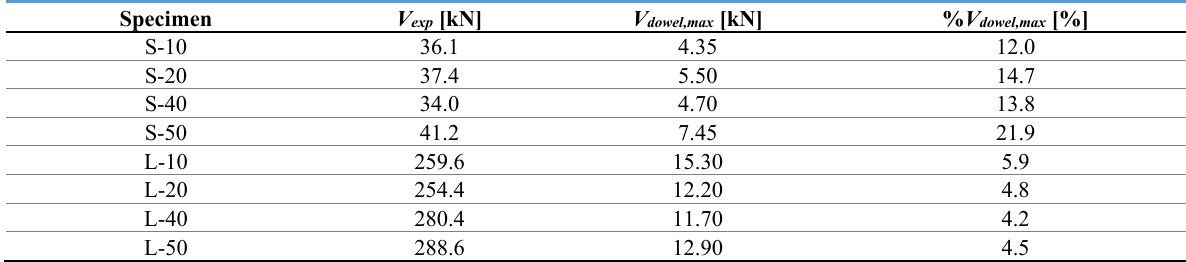
Table 6. Maximum shear forces obtained by the dowel action on the results of numerical analysis. Specimen V exp [kN] V dowel,max [kN] % V dowel,max [%]